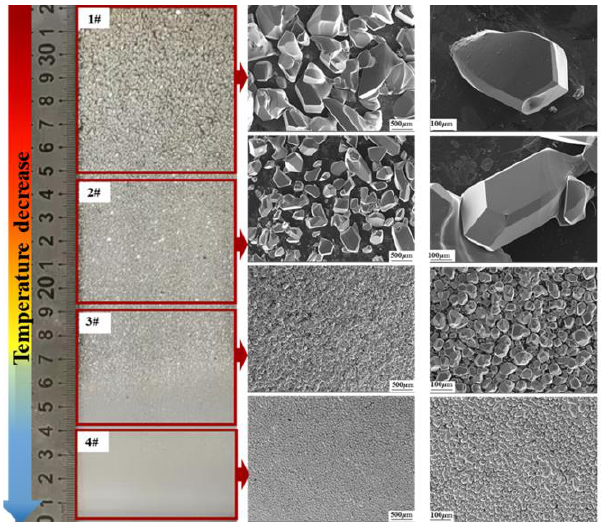
Figure 7. Graphite paper condensation product maps and SEM images of different condensation regions.